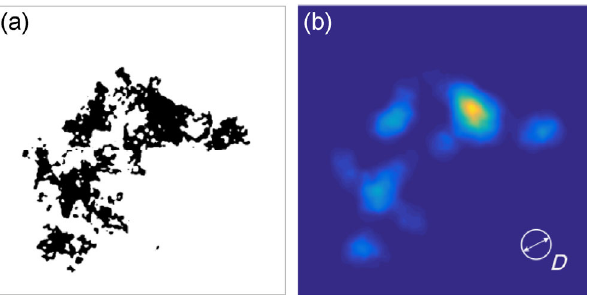
Fig. 3 (a) Contact configuration and (b) the corresponding energy density map for a given diameter D .